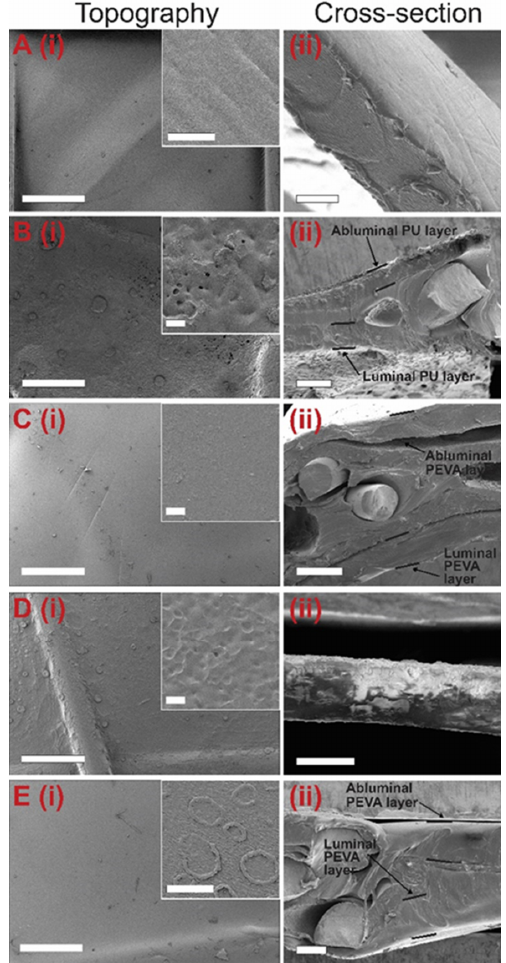
Figure 5. Representative scanning electron microscopy (SEM) images of the (i) abluminal topogra- phy (insets show high magnification images) and (ii) cross-section of coated stents before drug release: ( A ) Si-covered nitinol stent with no polymer coating, and ( B ) Si-PU 5FU , ( C ) Si-PU 5FU -PEVA, ( D ) B-PU 5FU , ( E ) B-PU 5FU -PEVA stents. Scale bars for A-E(i) = 500 microns, A-E(i) inset = 10 microns, A(ii) = 10 microns, B(ii) = 100 microns, C(ii) = 200 microns, D(ii) = 50 microns and E(ii) = 100 microns.